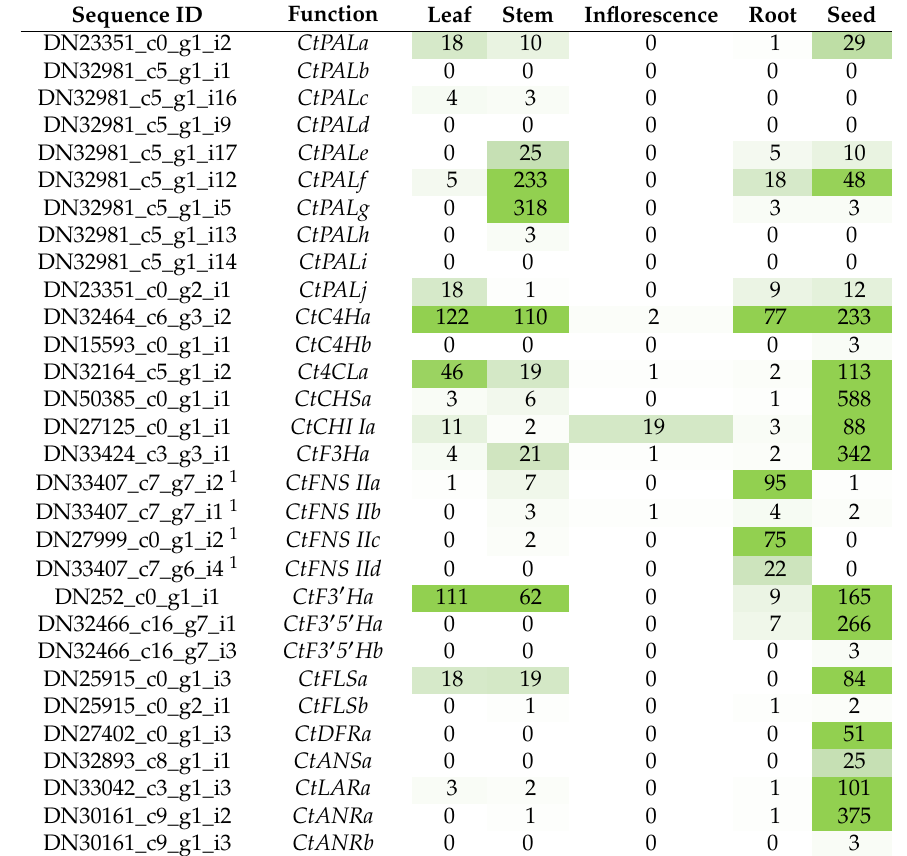
Table 1. Candidates in the flavonoid biosynthesis of Croton tiglium . “TRINITY” prefix of all sequence names was omitted for brevity. Candidates are sorted by their position in the respective pathway and decreasing similarity to bait sequences. Transcripts per million (TPM) values of the candidates in di ff erent tissues are shown: leaf (SRR6239848), stem (SRR6239849), inflorescence (SRR6239850), root (SRR6239851), and seed (SRR6239852). Displayed values were rounded to the closest integer, and